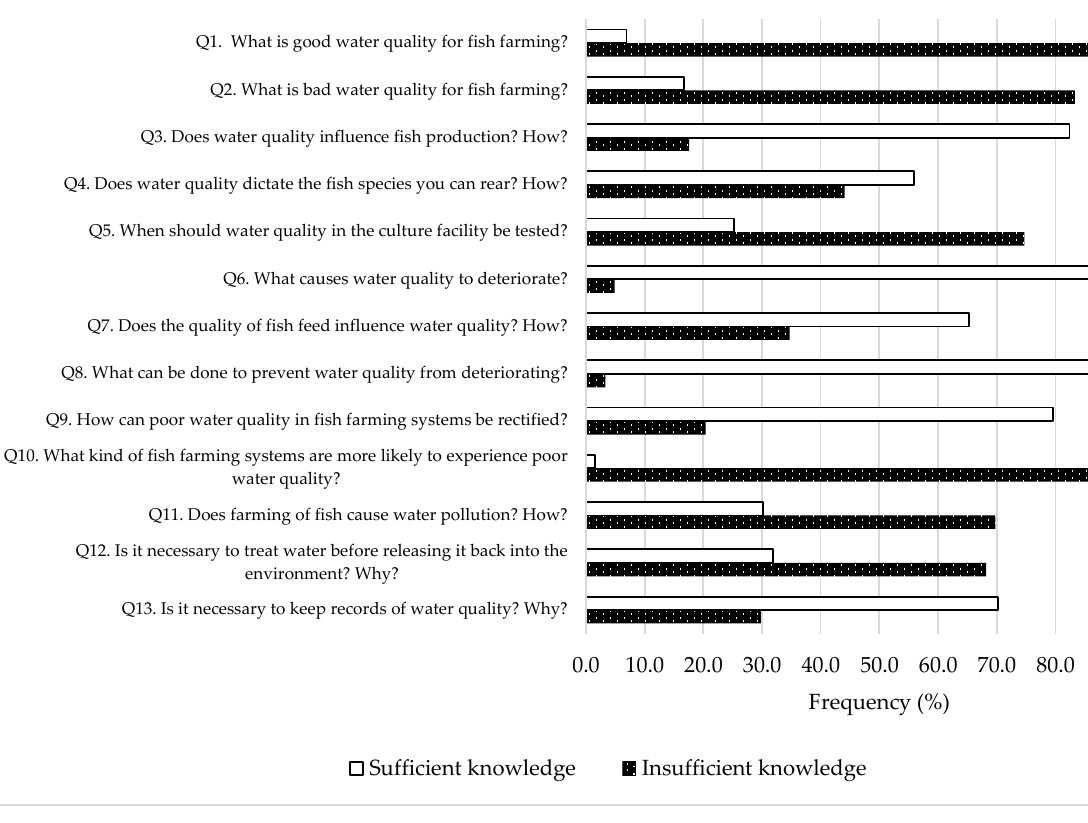
Figure 2. Percentage frequencies of correct (sufficient knowledge) and incorrect (insufficient knowl- fish farmers of the Rwenzori region,